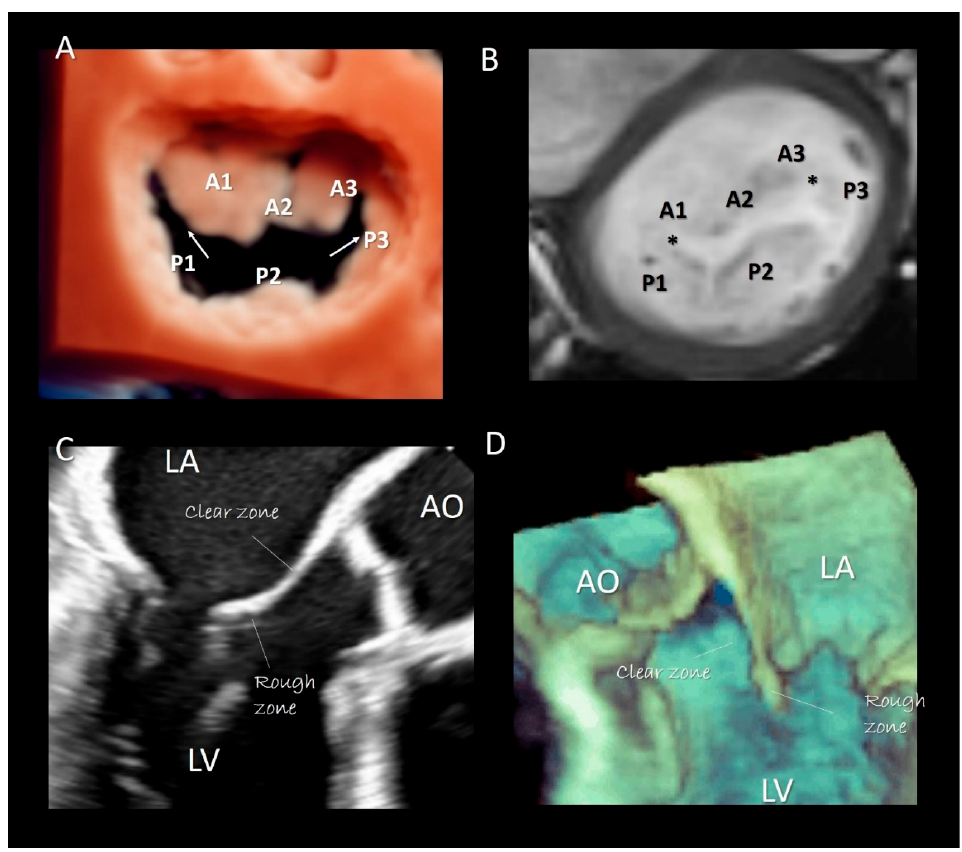
Figure 5. ( A ) 3D TEE with a new volume rendering algorithm from an overhead view, showing the two commissure (arrows) and the P1, P2, P3 scallops of the posterior leaflet. A1, A2, A3 are the corresponding segments of anterior leaflet. ( B ) CMR cross-section short-axis at the level of mitral leaflets showing the commissures (asterisks) and the scallops. ( C ) 2D TEE and ( D ) 3D TEE cross-section long-axis views showing the rough and clear zones.